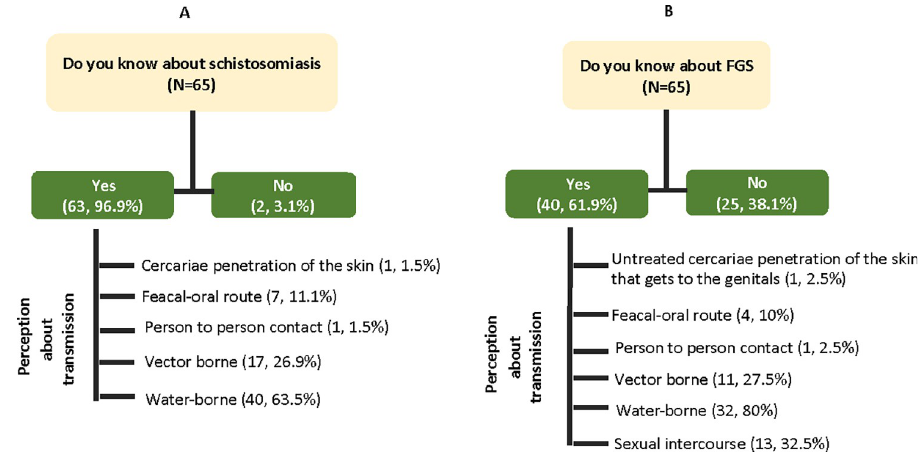
Fig 3. Knowledge of health care professionals about schistosomiasis and FGS.